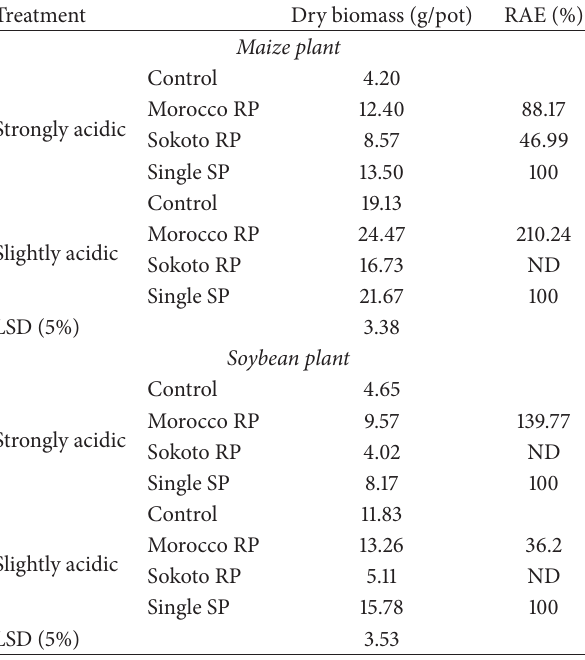
Table 5: Influence of soils and P-sources on dry biomass yield (g/pot) and relative agronomic efficiency (RAE) (%) of maize/soy- bean plants in the first